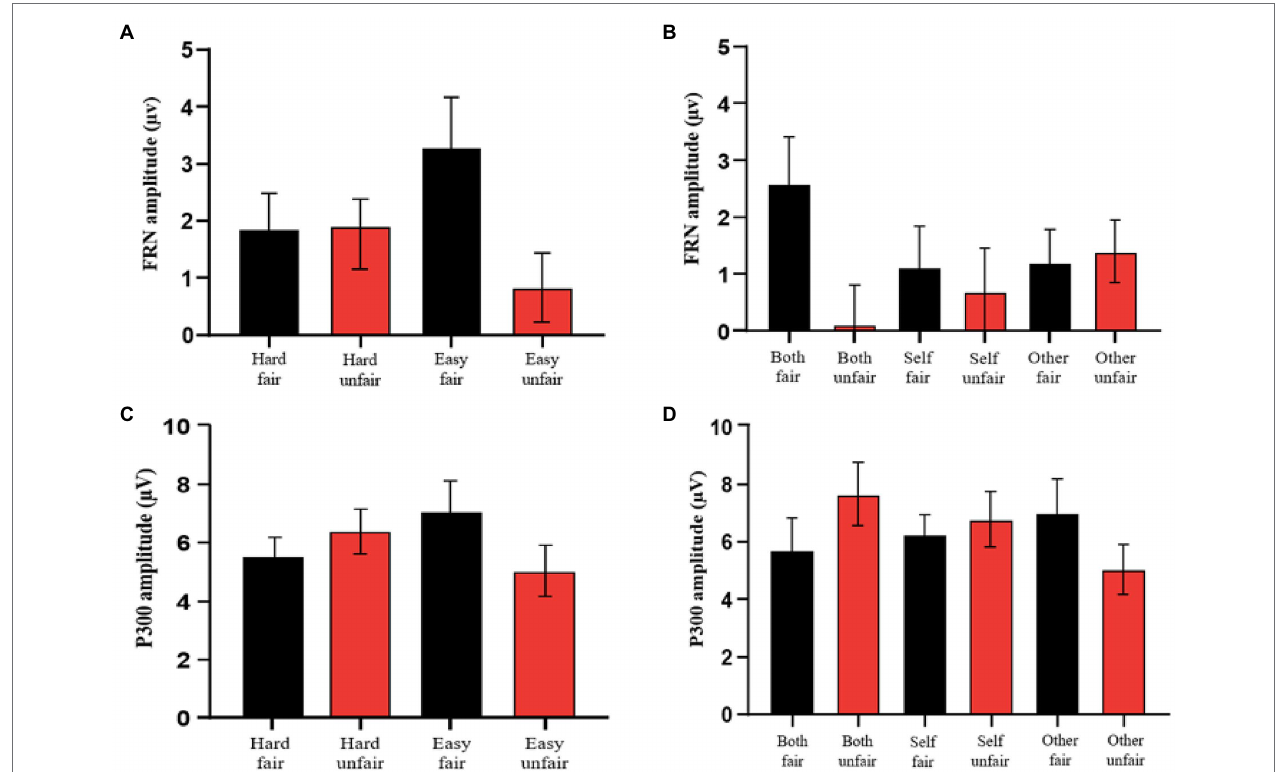
FIGURE 4 | ERP amplitudes. (A) Comparison of FRN amplitudes across difficulty and fairness conditions. (B) Comparison of FRN amplitudes across contribution and fairness conditions. (C) Comparison of P300 amplitudes across difficulty and fairness conditions. (D) Comparison of P300 amplitudes across contribution and fairness